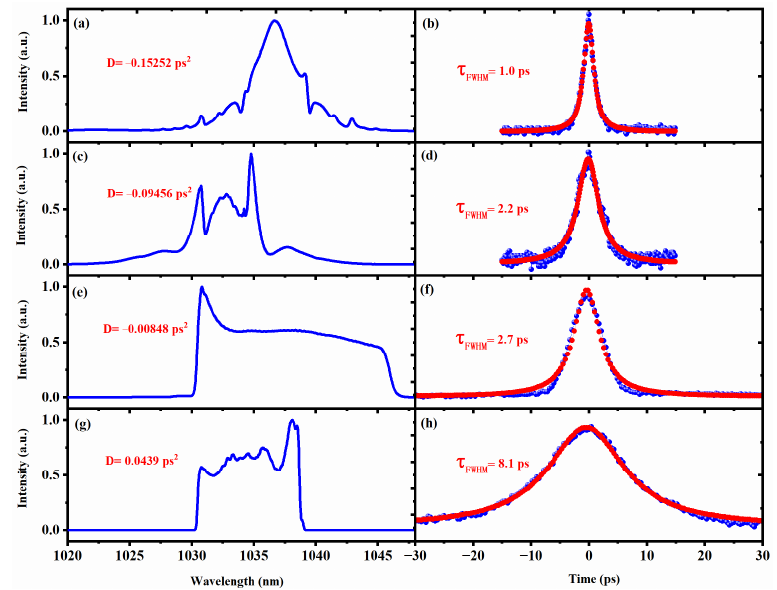
Figure 4. ( a , c , e , g ) Optical spectra at the different distances between the grating pair. ( b , d , f , h ) The corresponding autocorrelation traces.